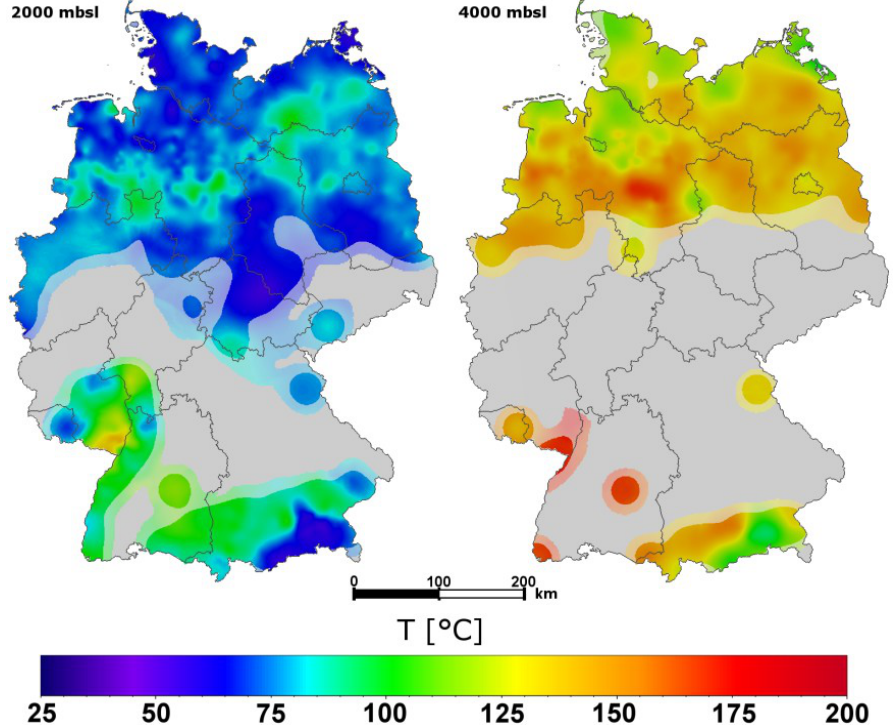
Figure 3. Maps of subsurface temperature distribution (mbsl: meters below sea